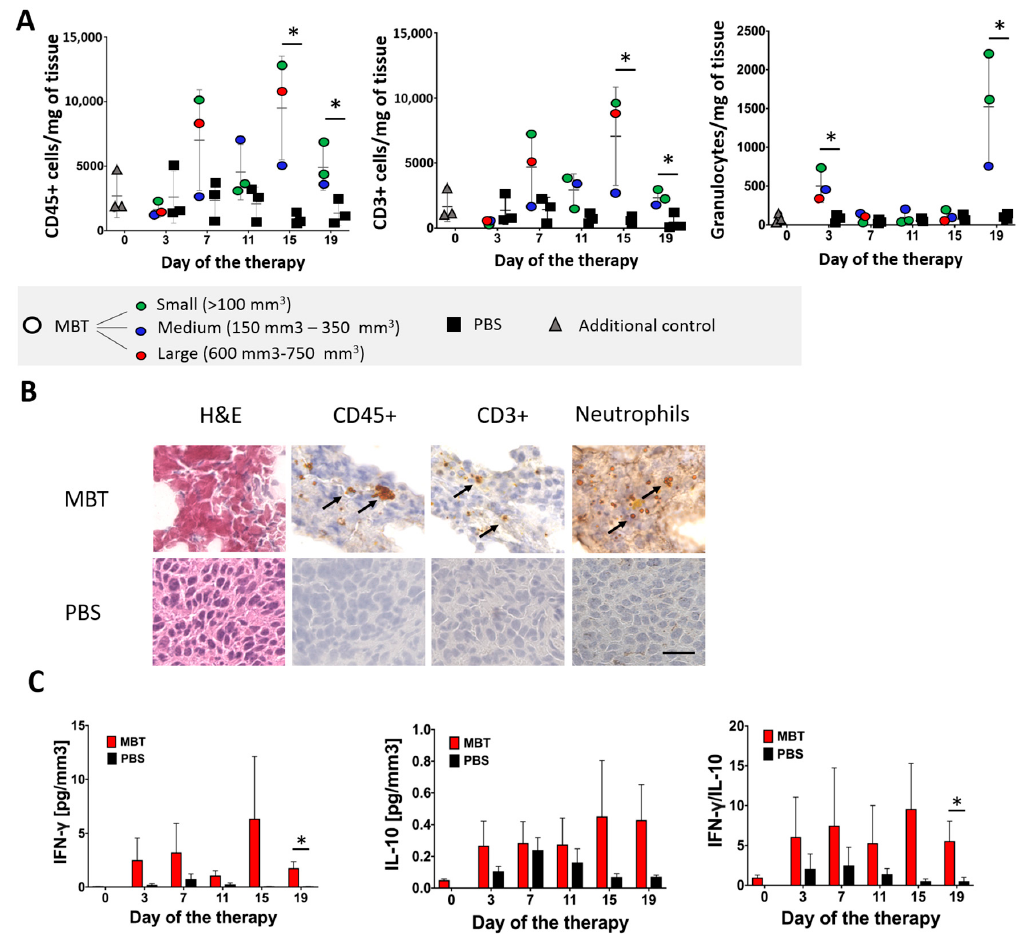
Figure 5. Flow cytometry and immunohistochemistry analysis of tumor-infiltrating leukocytes in the MBT-treated tumors. B6(Cg)- Tyr c-2J / J mice were subcutaneously injected with MTT-luciferase cells. After tumors grew to the desired size (about 100 mm 3 ), mice were randomized into two groups ( n = 24 / group): (i) the group treated with MBT and (ii) the group treated with PBS. MBT and PBS were given intratumorally on days 0, 1, 2, 8, 9, 10, 16, 17, 18, 24, 25, and 26. Three mice from both groups were sacrificed on days 3, 7, 11, 15, and 19. One half of the harvested subcutaneous tumors was used for flow cytometry analysis of tumor-infiltrating leukocytes and the second half was used for immunohistochemistry analysis of tumor-infiltrating leukocytes. Three mice were sacrificed on day 0 and used as an additional control—gray triangles (no application of any compounds into the tumor). ( A ) The analysis of tumor-infiltrating CD45 + and CD3 + cells revealed their elevation on the 15th and 19th days of therapy in the MBT-treated group. Granulocytes (Ly6G + cells) were elevated on the 3rd and 19th days of therapy in the MBT-treated group. The results are presented as individual values for each mouse, with a color legend based on the size of the analyzed tumors. (* p < 0.05 against PBS). ( B ) Hematoxylin and eosin (H&E) staining and CD45 + , CD3 + , and Ly6G/Ly6C immunohistochemistry staining were performed on tumor cryosections (a thickness of 8 µm). Bar = 20 µm. ( C ) IFN- γ levels, measured by ELISA from tumor supernatants collected during tumor-infiltrating leukocyte analysis revealed significantly higher levels in the MBT-treated group compared to the PBS-treated group. The group (* p < 0.05 against